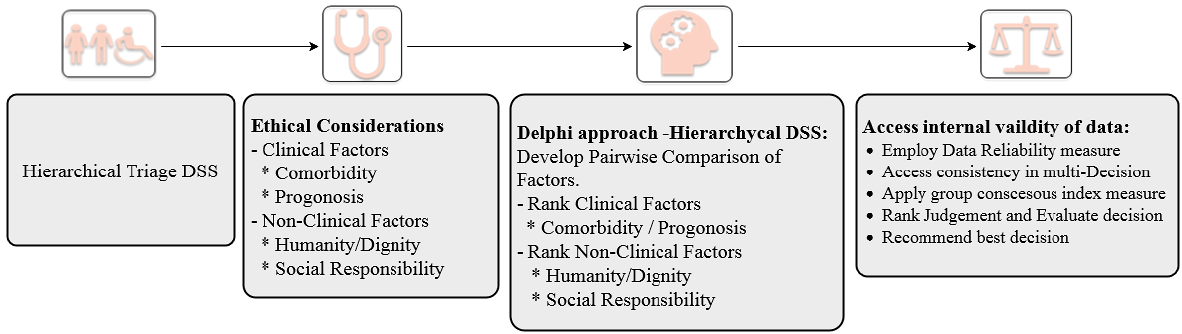
Figure 2. Hypothesized framework of the triage decision Multi-Factor Triage Algorithm,